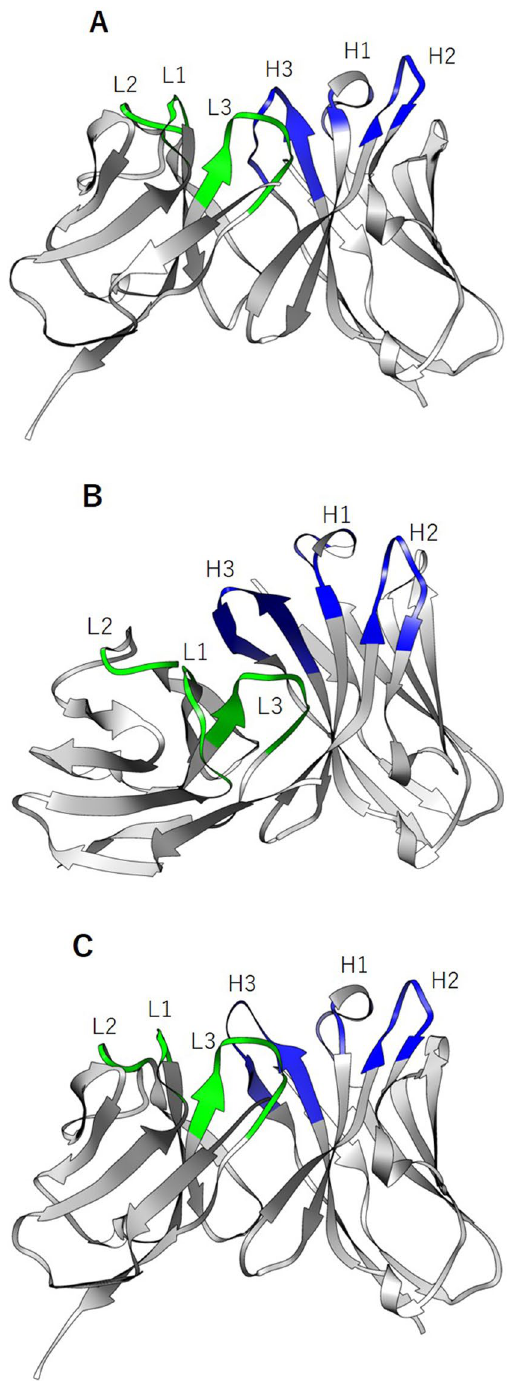
Figure 5. Predicted V H and V L structures of mA10 ( A ), A10/8A7 ( B ), and A10/16E8 (C) by the Rosetta software. The CDR loops of the heavy (H1–H3) and light (L1–L3) chains are indicated with blue and green,